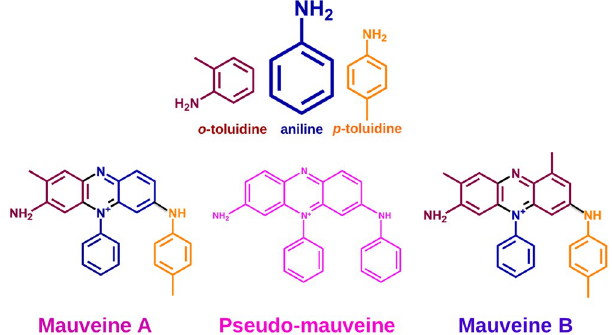
Figure 1. Chemical structures of aniline, o- toluidine and p- toluidine used in the synthesis of mauveine. The combination of these starting materials leading to mauveine A and B, two of the major components in mauveine samples, is depicted in different colours. Pseudo-mauveine consisting of a non-methylated structure is also